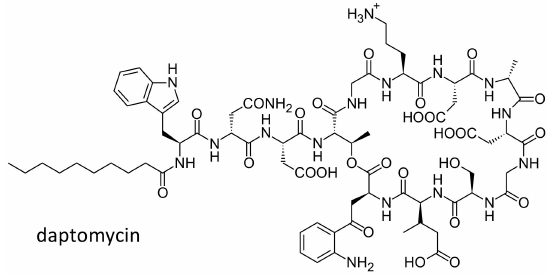
Figure 9. Chemical structure of daptomycin.